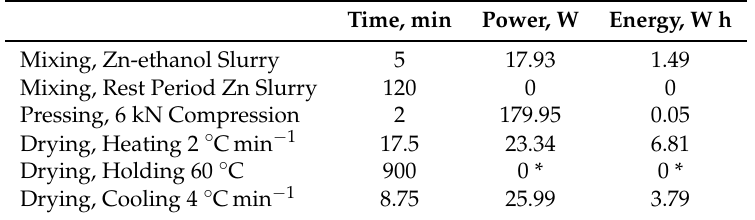
* Assumed ideal, perfectly insulated conditions.